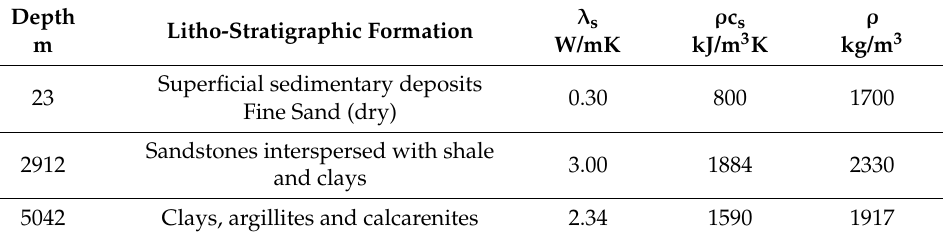
Table 2. Tempa Rossa 1D hydrocarbon well-lithostratigraphic profile (Tempa Rossa Field, Western Po Plain).